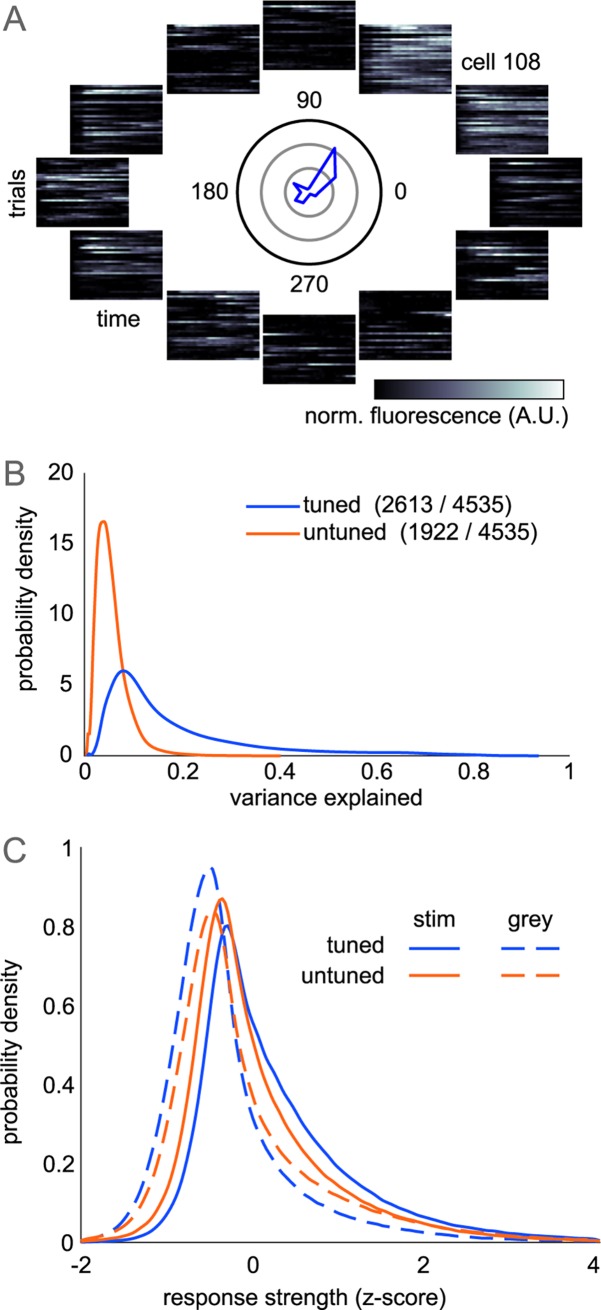
Single trial response variability.(A) Single trial responses of representative tuned neuron. Mean tuning curve in polar coordinates shown in center (rings = 100% dF/F0). Each heatmap positioned by grating direction shows normalized time-varying activity for each trial. (B) Trial-averaged tuning responses do not explain trial-to-trial variability. Tuning average (blue curve in A) is subtracted from mean fluorescence in each trial to compute variance explained across trials. (C) Averaging across time, neurons show highly variable responses during grating and grey trials with a right-skewed distribution due to strong activity in a few trials. Tuned neurons show larger increase in response during gratings than untuned neurons.